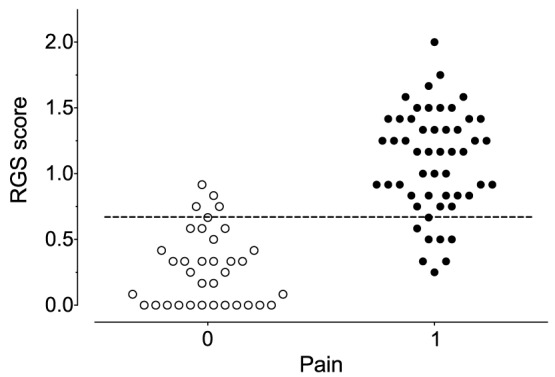
Scatter plot of Rat Grimace Scale scores categorised by “no pain” (0) and “pain” (1) assignment.Images of rat faces were scored by expert raters and classified as “pain” or “no pain” based on subjective evaluation. The dashed horizontal line shows the analgesic intervention score of 0.68. There is clear overlap between the two assigned pain states, reflective of the balance in sensitivity and specificity. n = 87 images